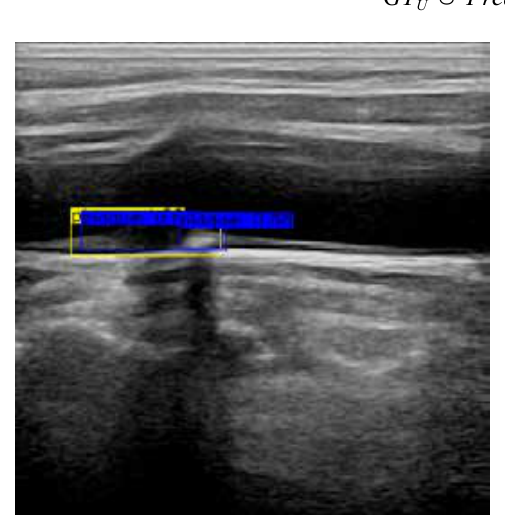
Thus, we define the union of the ground truths as GT = U M GT and the union of the predicted results as Pred i=1 i = U N Pred . We then calculate the intersection over i=1 i and Pred union (IoU) of GT U